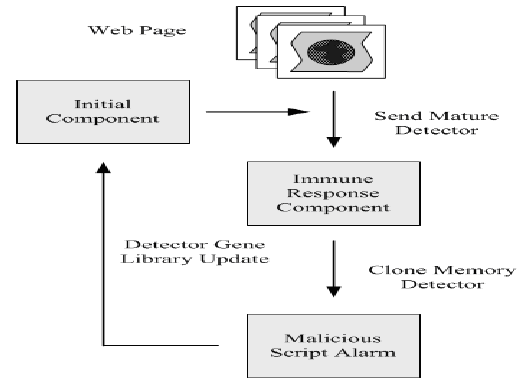
Fig. 1. The architecture of